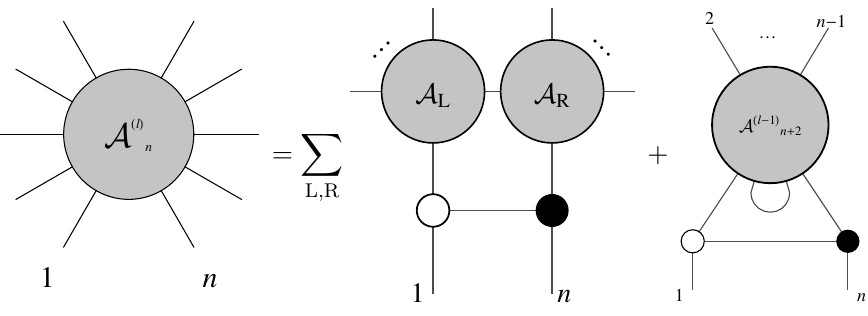
Figure 2 . Loop-level BCFW recursion for planar N = 4 SYM.